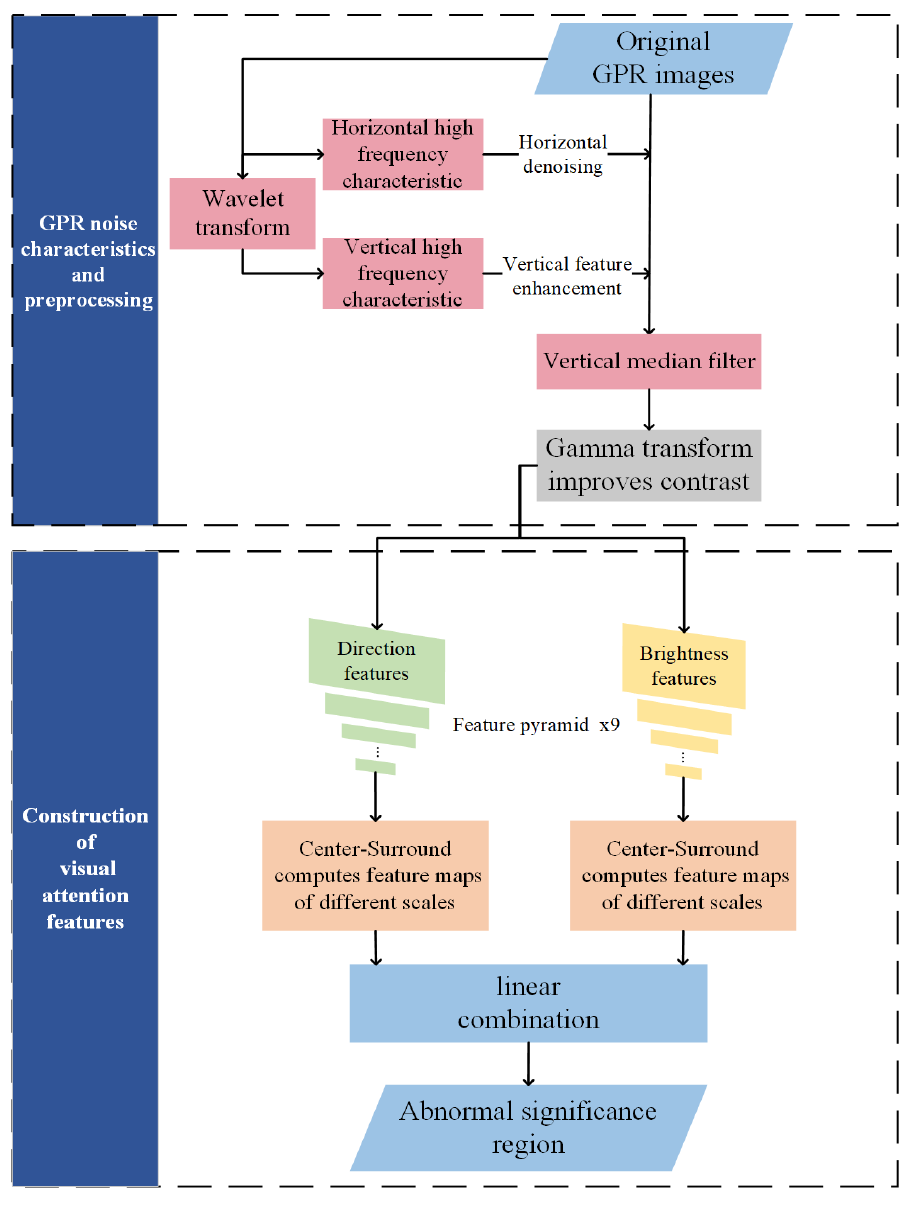
Figure 2. Algorithm processing flow chart.